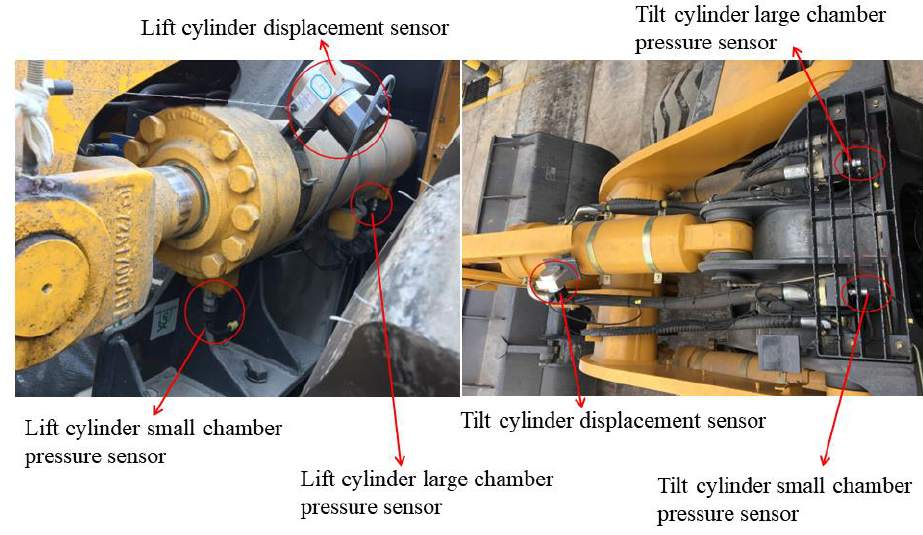
Figure 12. Sensors.